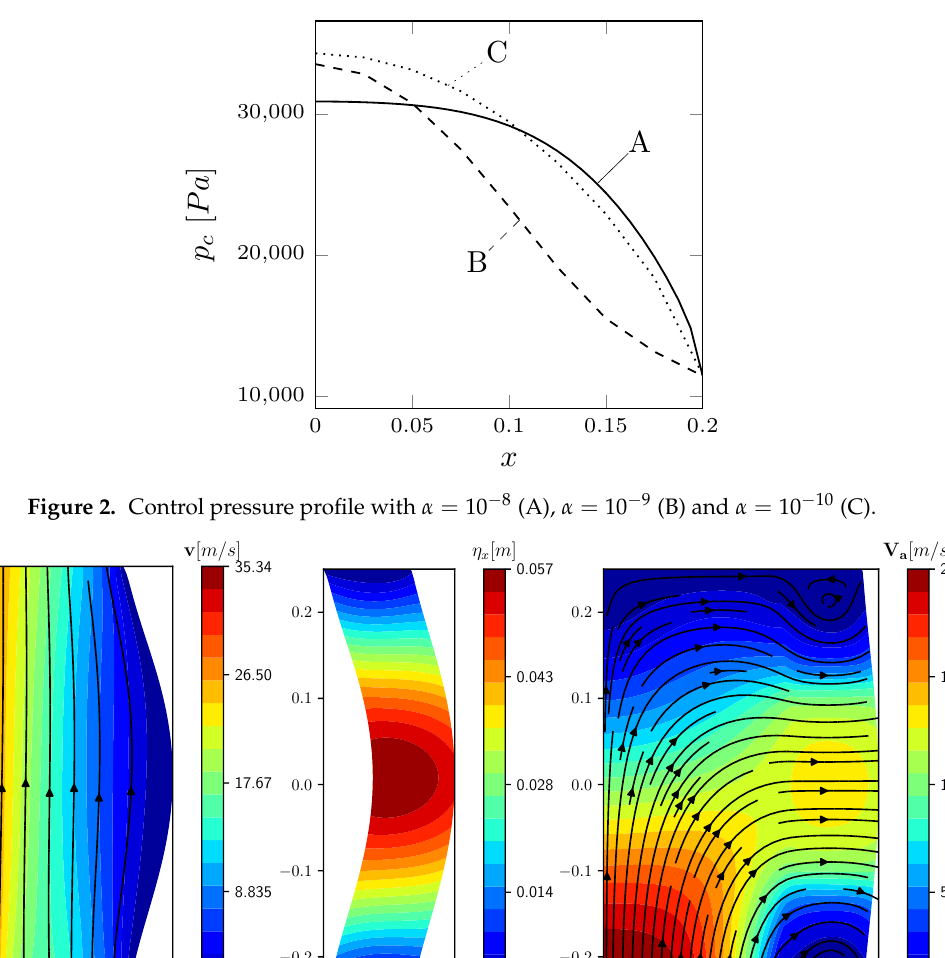
Figure 3. Controlled case with velocity profiles v and streamlines in the liquid ( left ) and displacement η in the solid ( center ). Adjoint velocity v a field and streamlines for the reference case configuration ( right